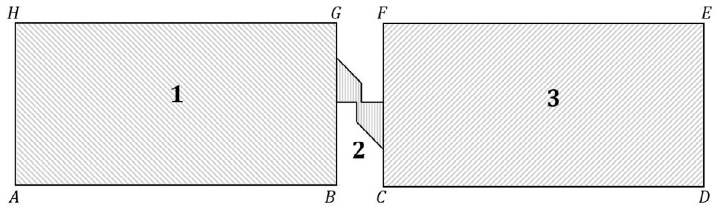
Figure 5. Two-dimensional computational domain for the plate of thickness t p and slit width b enclosed between an upstream and a downstream channel. Three sub-domains (1-2-3) are de fi ned for meshing